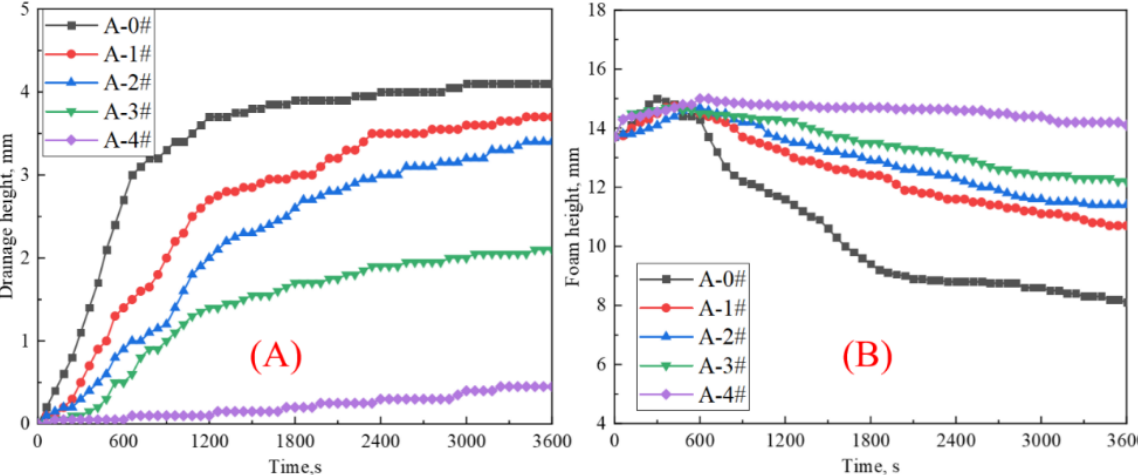
Figure 4. ( A ) The height of drainage varies with heating time. ( B ) Foam layer height varies with heating time.